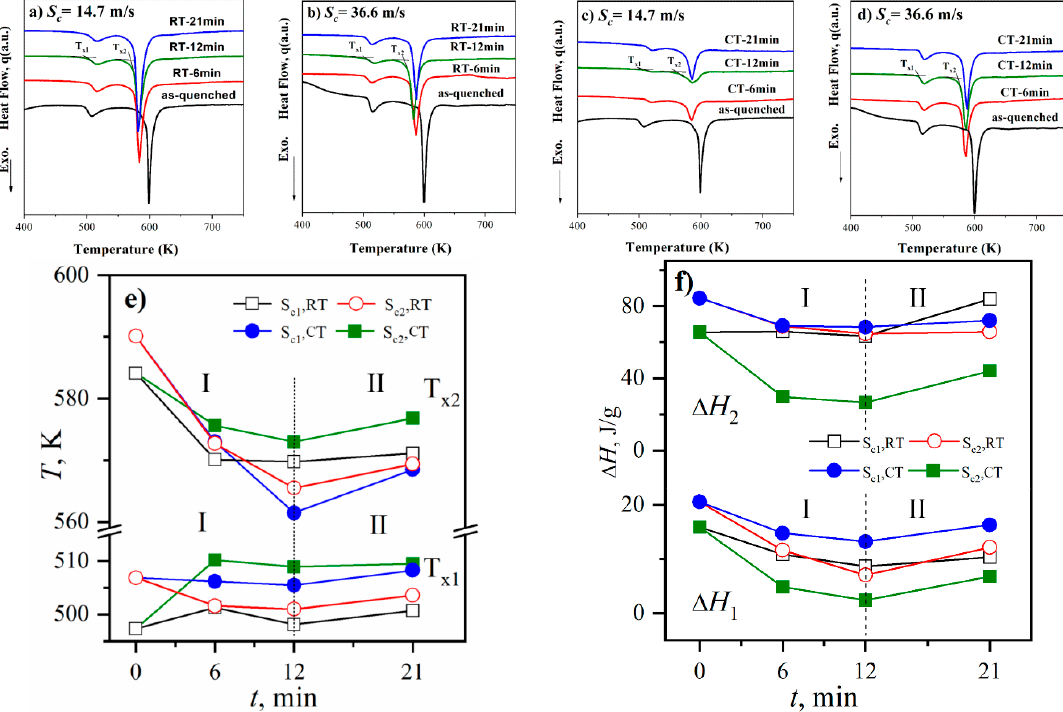
Figure 5. DSC curves of the milled Al 86 Ni 9 La 5 samples with different S c and different milling temperatures: ( a ) RT, S c = 14.7 m/s; ( b ) RT, S c = 36.6 m/s; ( c ) CT, S c = 14.7 m/s; ( d ) CT, S c = 36.6 m/s. The onset temperature ( T x1 , T x2 ) and crystallization enthalpy ( ∆ H 1 , ∆ H 2 ) calculated from the DSC curves are performed as a function of milling time in ( e , f ), where S c1 represents S c = 14.7 m/s and S c2 represents S c = 36.6 m/s.